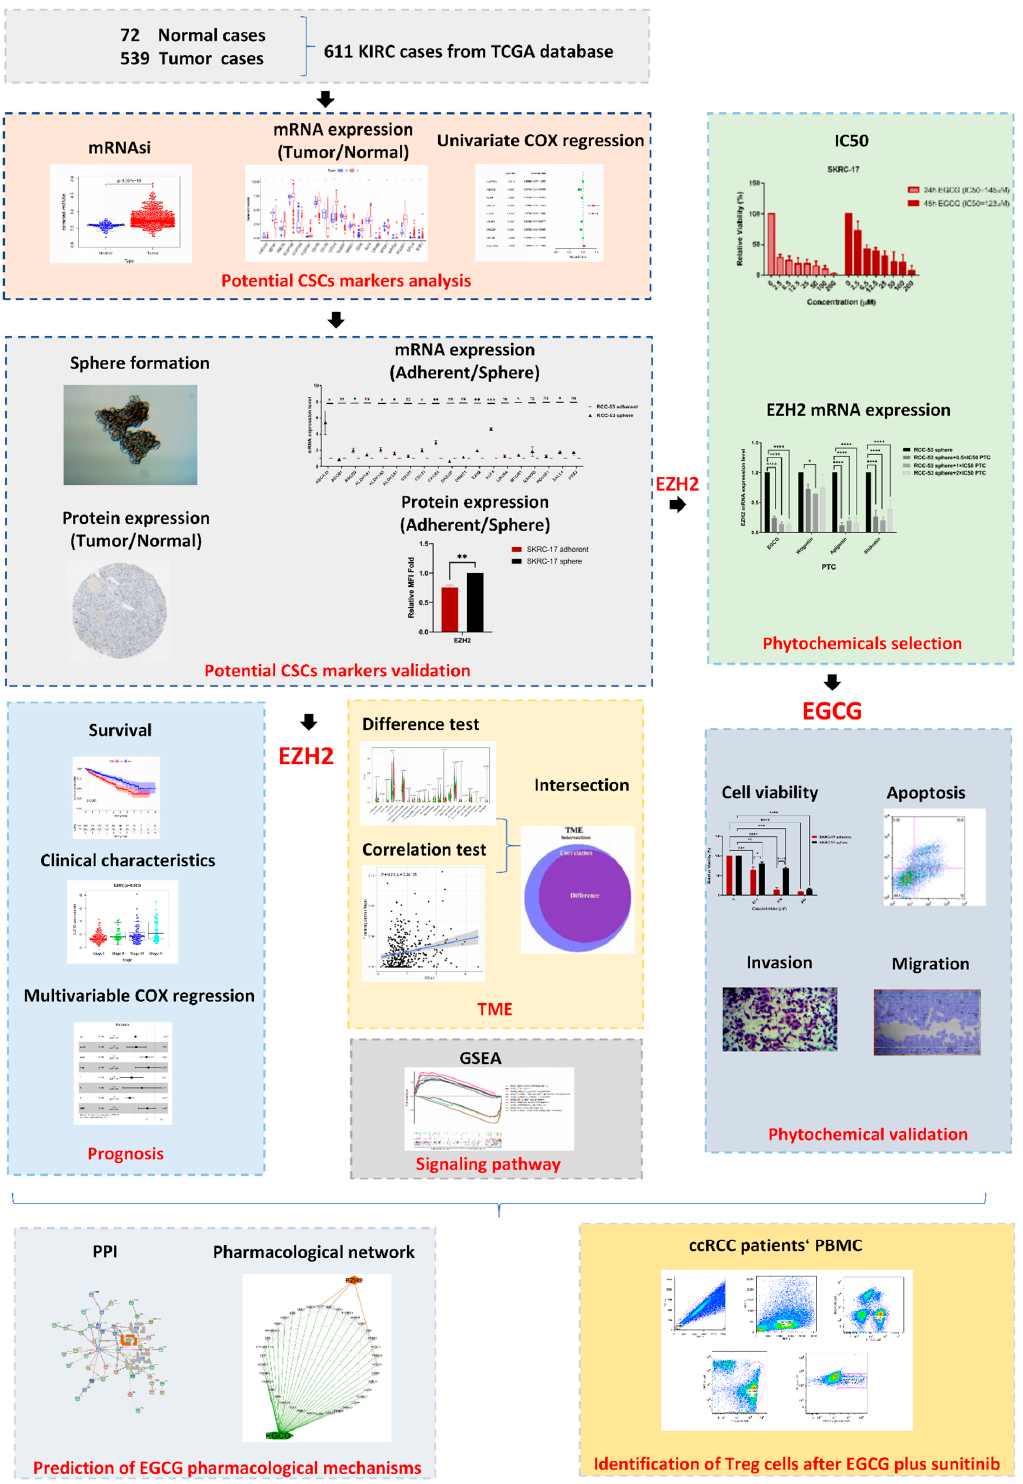
Figure 1. The analysis workflow of this study.